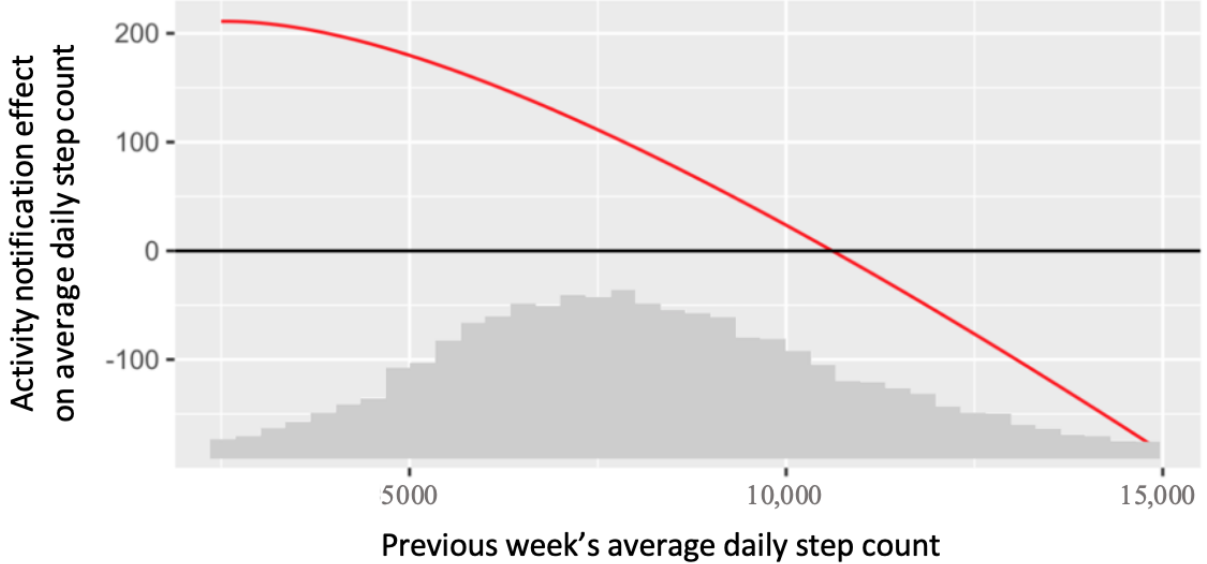
Figure 6. Estimated treatment effects (compared with no notifications) of activity notifications on average daily steps, at various values of previous week’s step counts. The x-axis also contains a scaled histogram of previous week’s average daily step